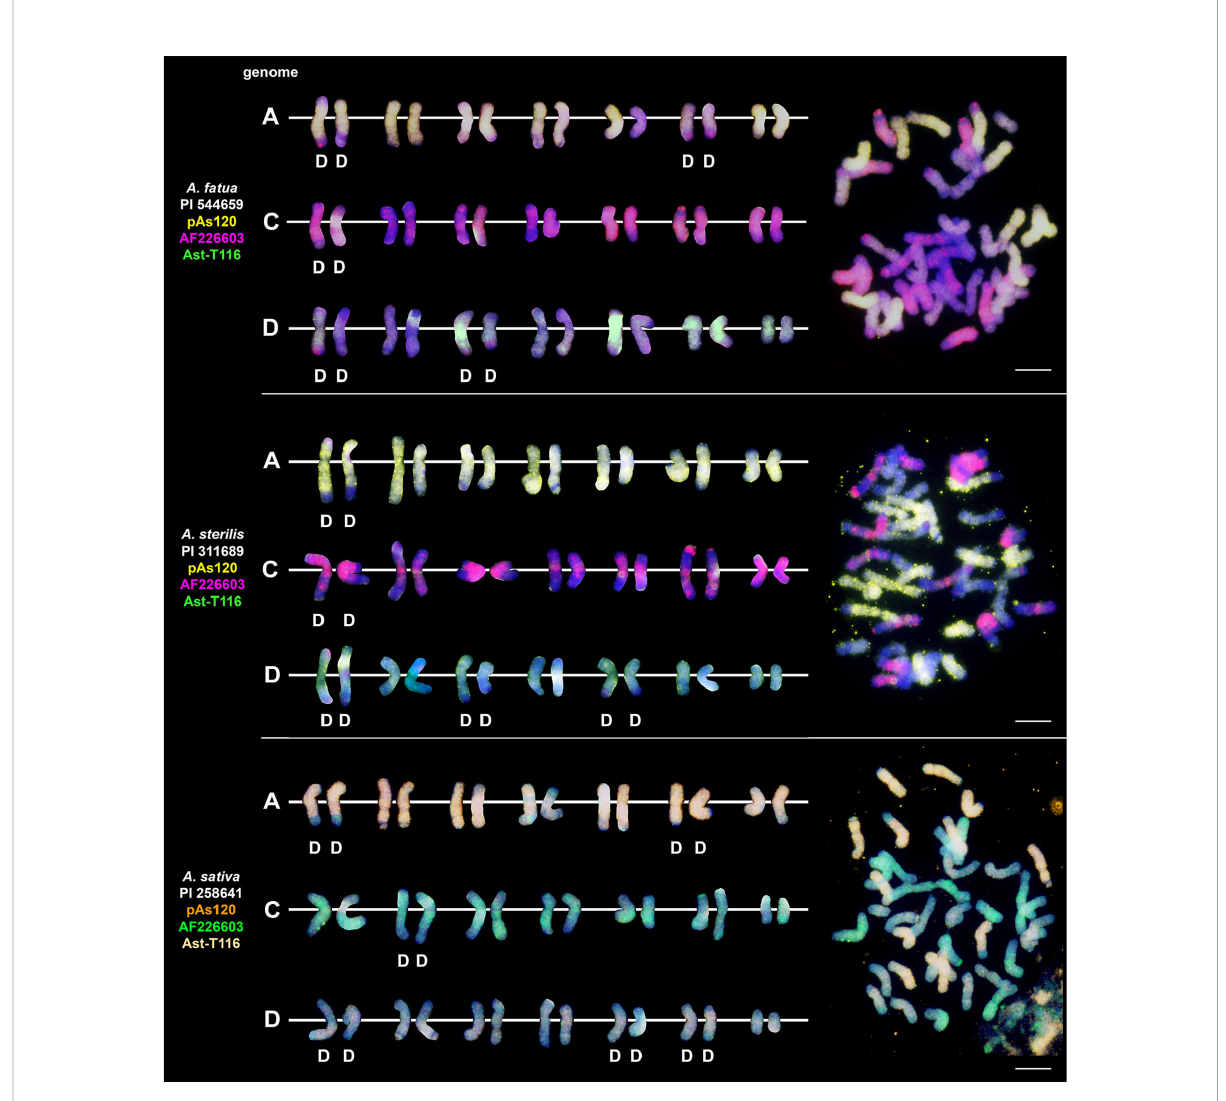
FIGURE 4 The diversity of intergenomic chromosome translocations across different hexaploid oat species. D- distal translocation. Scale bar = 10 m